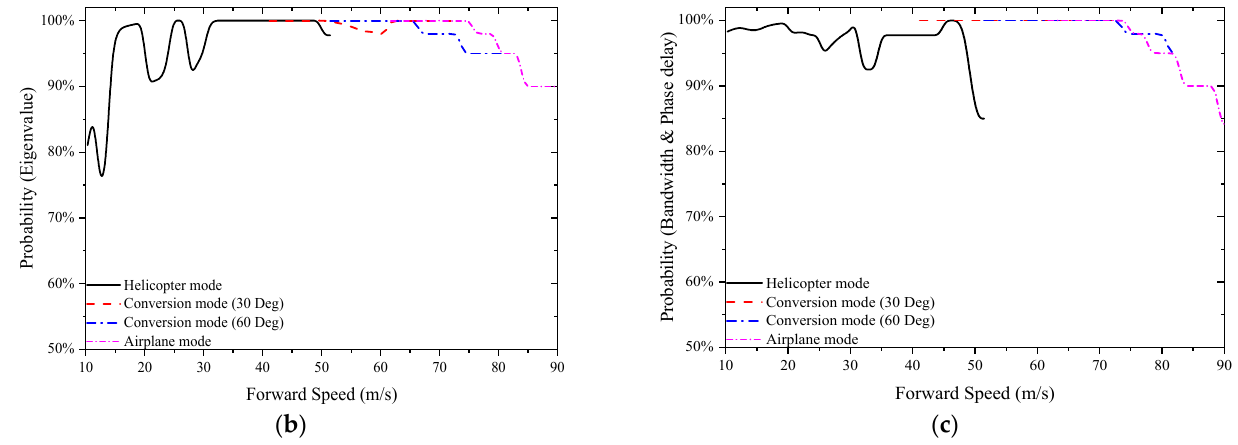
Figure 3. Aerodynamic uncertainty quantification results. ( a ) Overall probability results; ( b ) Eigen- value probability results; ( c ) Bandwidth and Phase delay probability results.